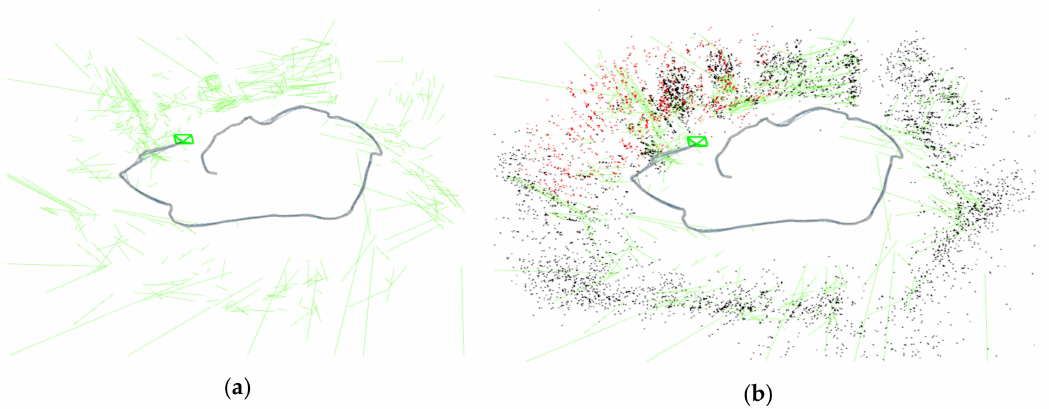
Figure 4. Stereo PL-SLAM performed in an artificial pool. ( a ) The green line represents the line features in the global map. The green quadrilateral box represents the current camera. The grey rough line represents the trajectory; ( b ) The red and black points represent the current local map points and global map points.